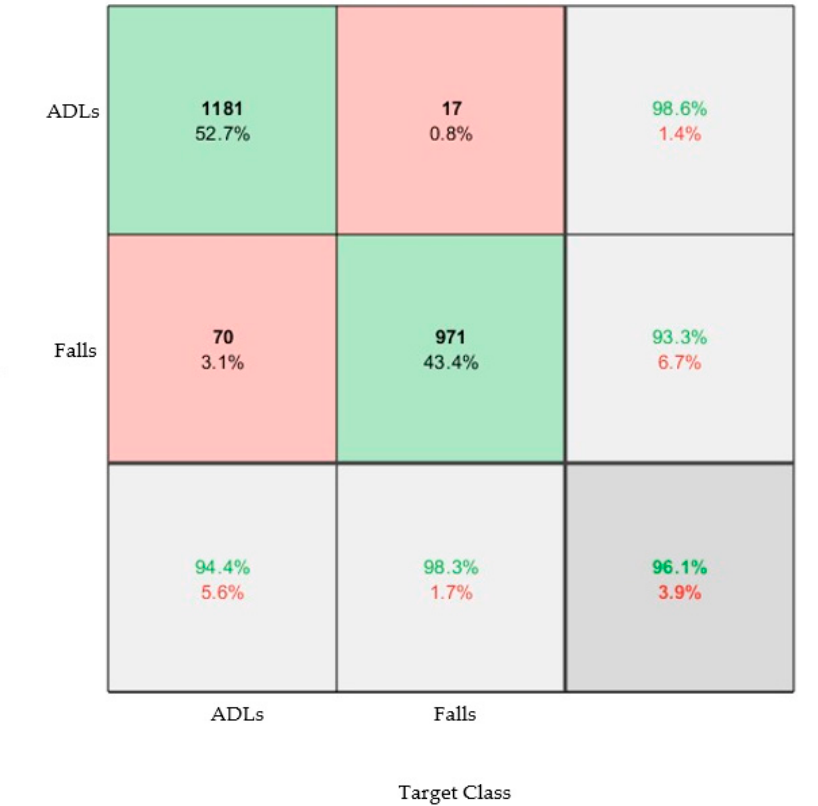
Figure 8. Confusion matrix that classifies between the three types of ADL (walking, sit to stand, timed up and go) and the three types of fall. The model was trained and tested using datasets from both feet and both the acceleration and angular velocity